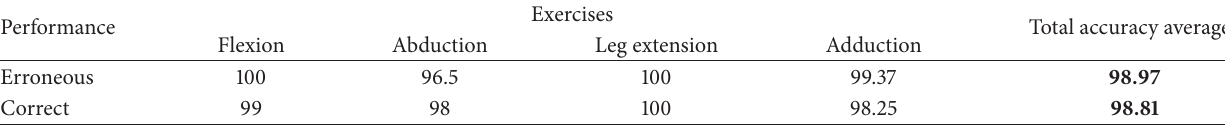
Table 1: Results of gestures recognition. Percentage accuracy values.